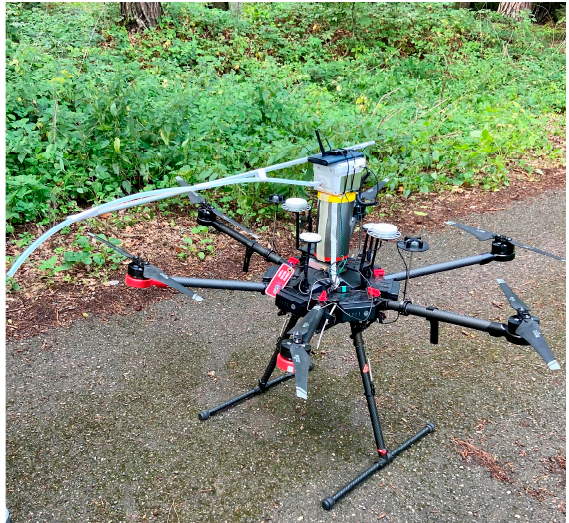
Figure 4. Electronic nose Sniffer 4D placed on multi-copter DJI Matrice 600; Teflon meter tube was used for sampling air.